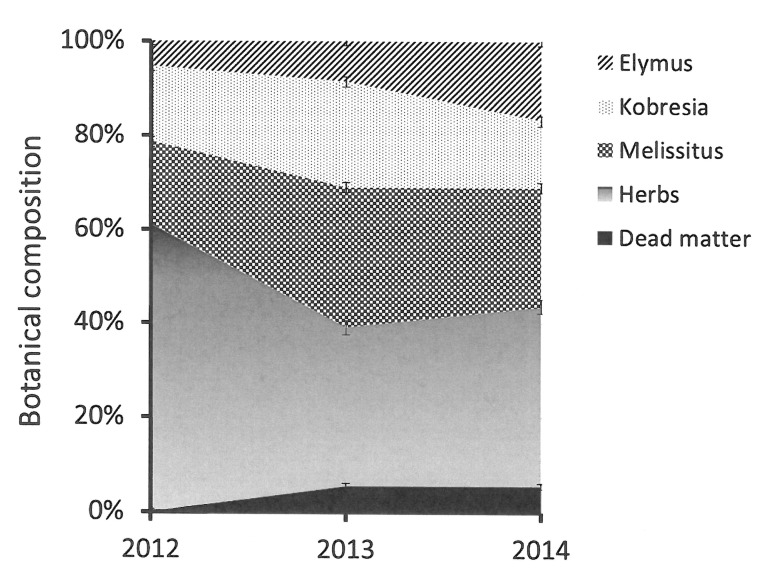
Change in botanical composition (%) of various species/categories (Elymus nutans, Kobresia humilis, M. ruthenica, forbs and dead matter) from 2012 to 2014.Bars represent the standard error of the mean.